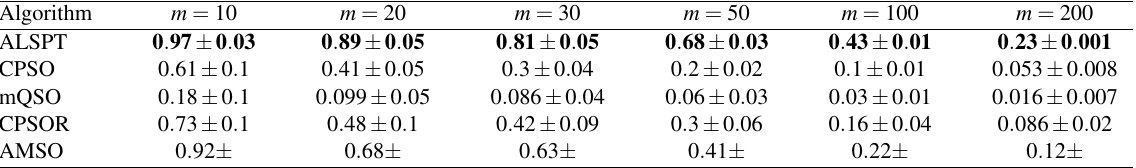
Table 13. tRatio and standard deviation obtained by ALSPT and four population-based state-of- the-art algorithms considered in the MPB benchmark for different number of peaks. The standard deviations for AMSO are not displayed because they were not available in the literature.